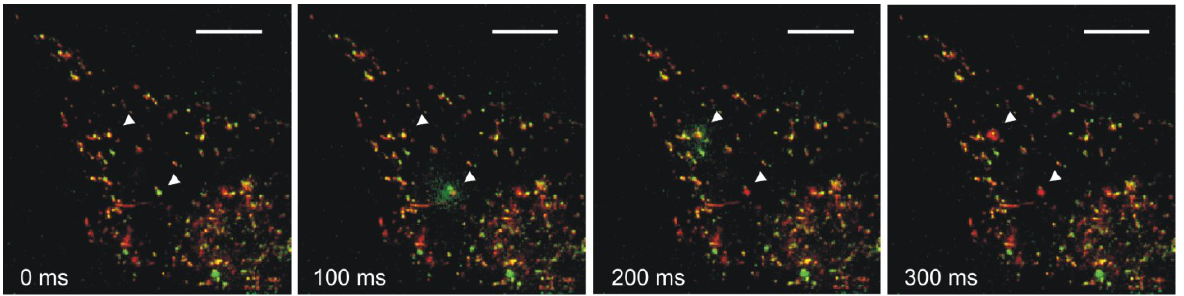
Figure 2. Lysosomes secreting Hsp70 from melanoma cells. Stable clones of mouse